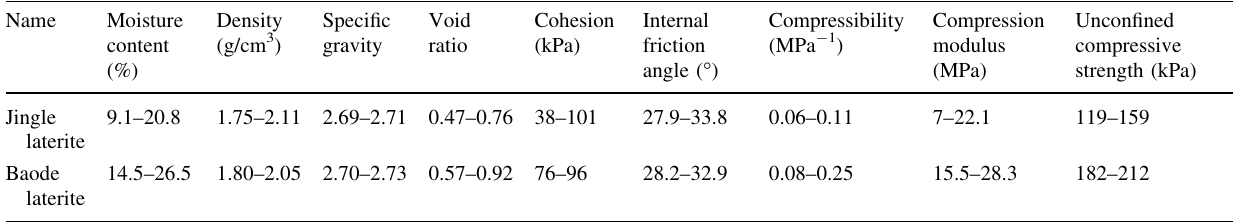
Table 3 Basic mechanical properties of clay